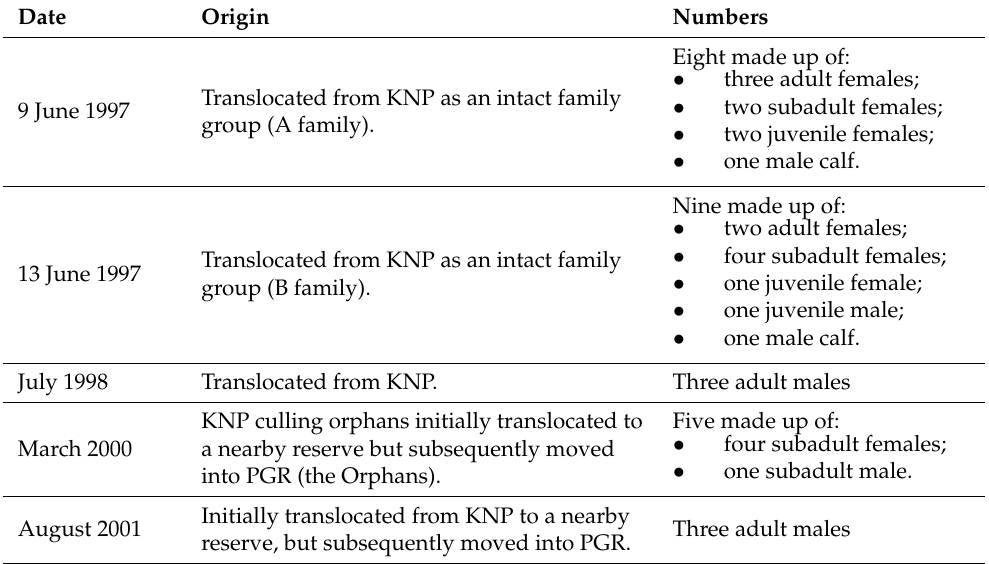
Figure 1. The geographical arrangement of reserves comprises the Pongolapoort ecosystem. GR = Game Reserve (private). NR = Nature Reserve (provincial). The bold dark red line indicates the international border between South Africa and Eswatini (formerly Swaziland). Dubula is a private section west of the Pongola NR Western Shores. Table 1. PGR’s founding elephant population. Age classifications: adult ≥ 15 years, subadult ≥ 10 and <15 years, juvenile ≥ 2 and <10 years, and calf < 2